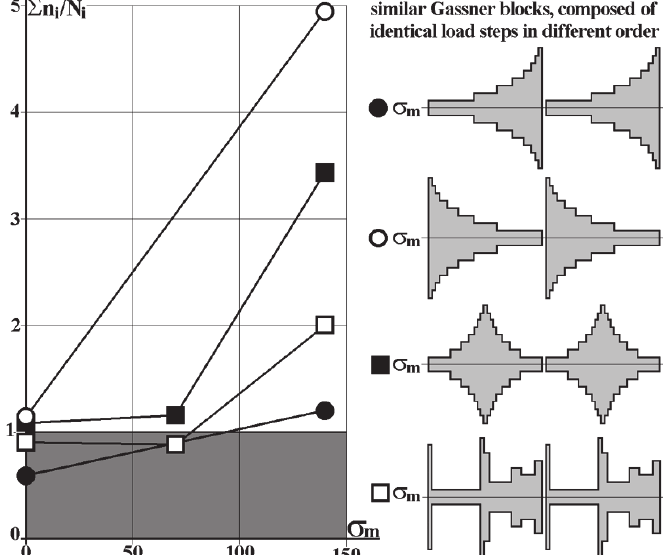
Figure 1: Step order and mean-stress effects on the lives of notched Al 7075-T6 test specimens with stress concentration factor 4, subjected to load blocks formed by the same load steps (these steps have the same mean stress  m , but practical spectra can produce steps with different  m )